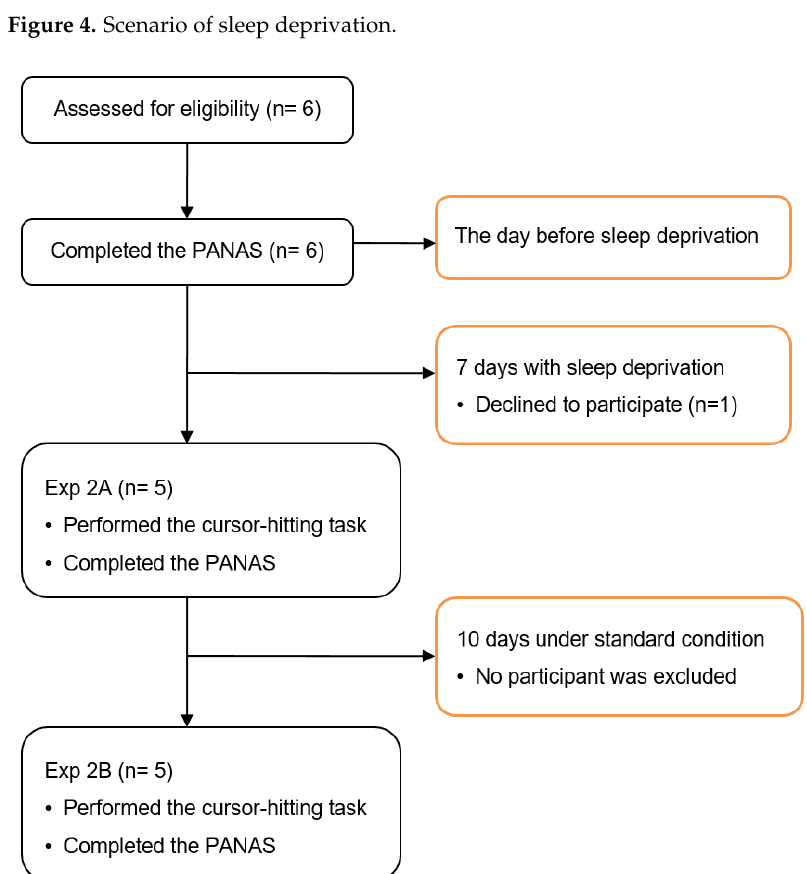
Figure 5. Consort flow diagram of Experiment 2. PANAS, The Positive and Negative Affect Sched- ule.